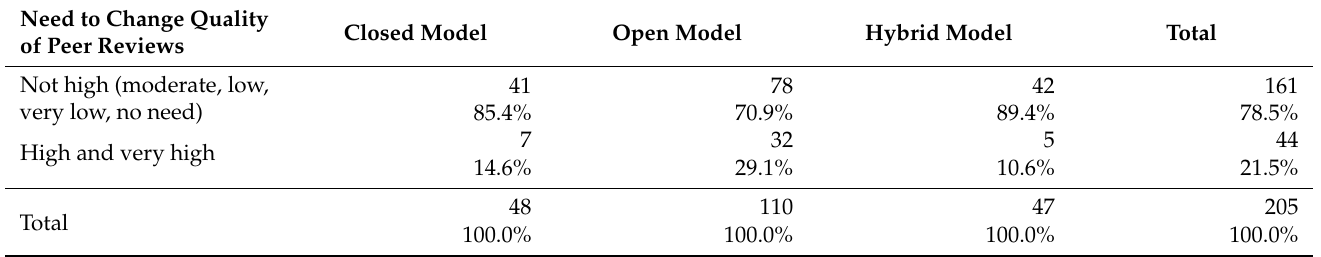
Table 8. Association between journal’s distribution model (closed, opened, hybrid) and respondent’s estimation of need to change quality of peer review